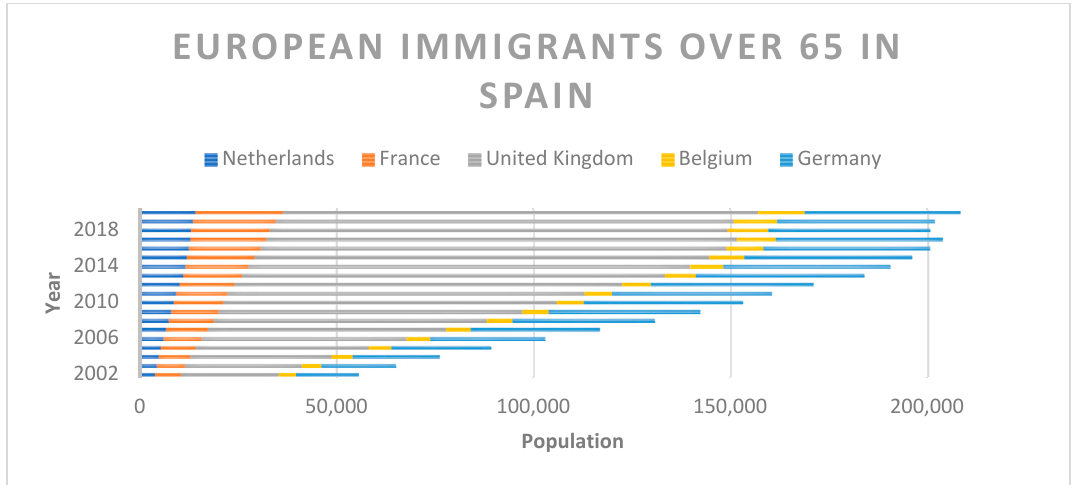
Figure 1. People over 65 years from five EU countries registered as residents in Spain. Source: Own elaboration with data from the Spanish National Statistical Institute (INE).